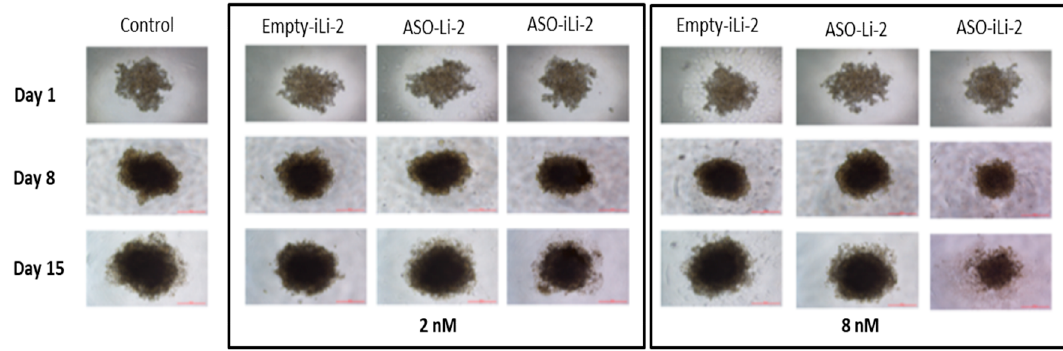
Figure 11. Spheroid (5000 cells) microscopy observations.